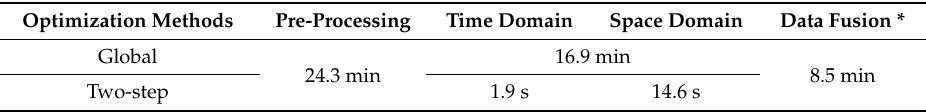
Table 1. Computation time consumption in optimization strategies.